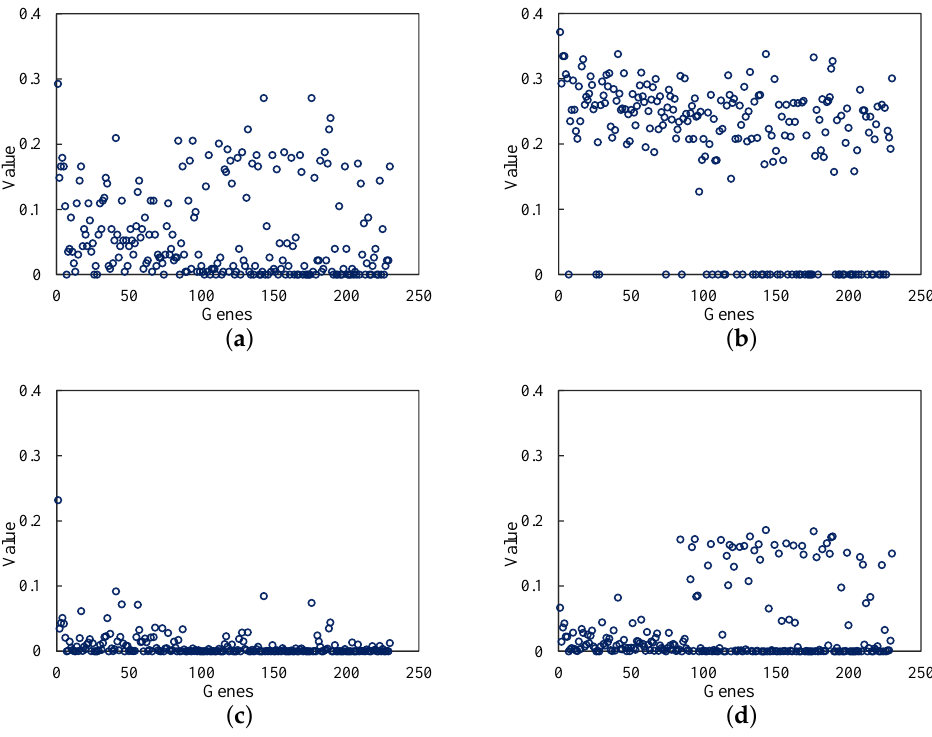
Figure 4. Node centrality analysis of 230 genes. The abscissa is a gene, which is represented by a number, and the ordinate is the result value of a gene calculated by the corresponding node centrality metric. ( a ) Degree centrality; ( b ) Closeness centrality; ( c ) Betweenness centrality; ( d ) Eigenvector